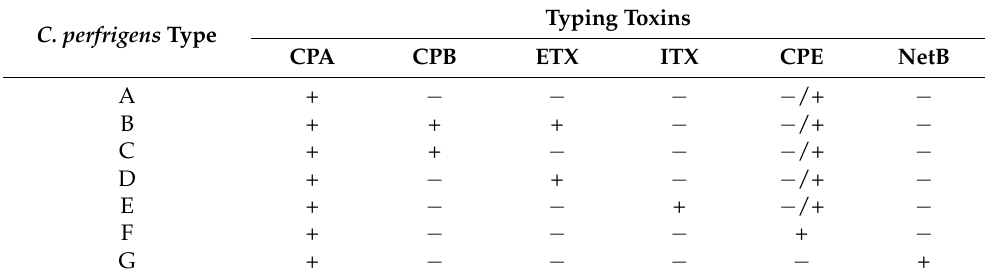
Table 1. Classification of Clostridium perfringens (Rood et al., 2018 [4]).